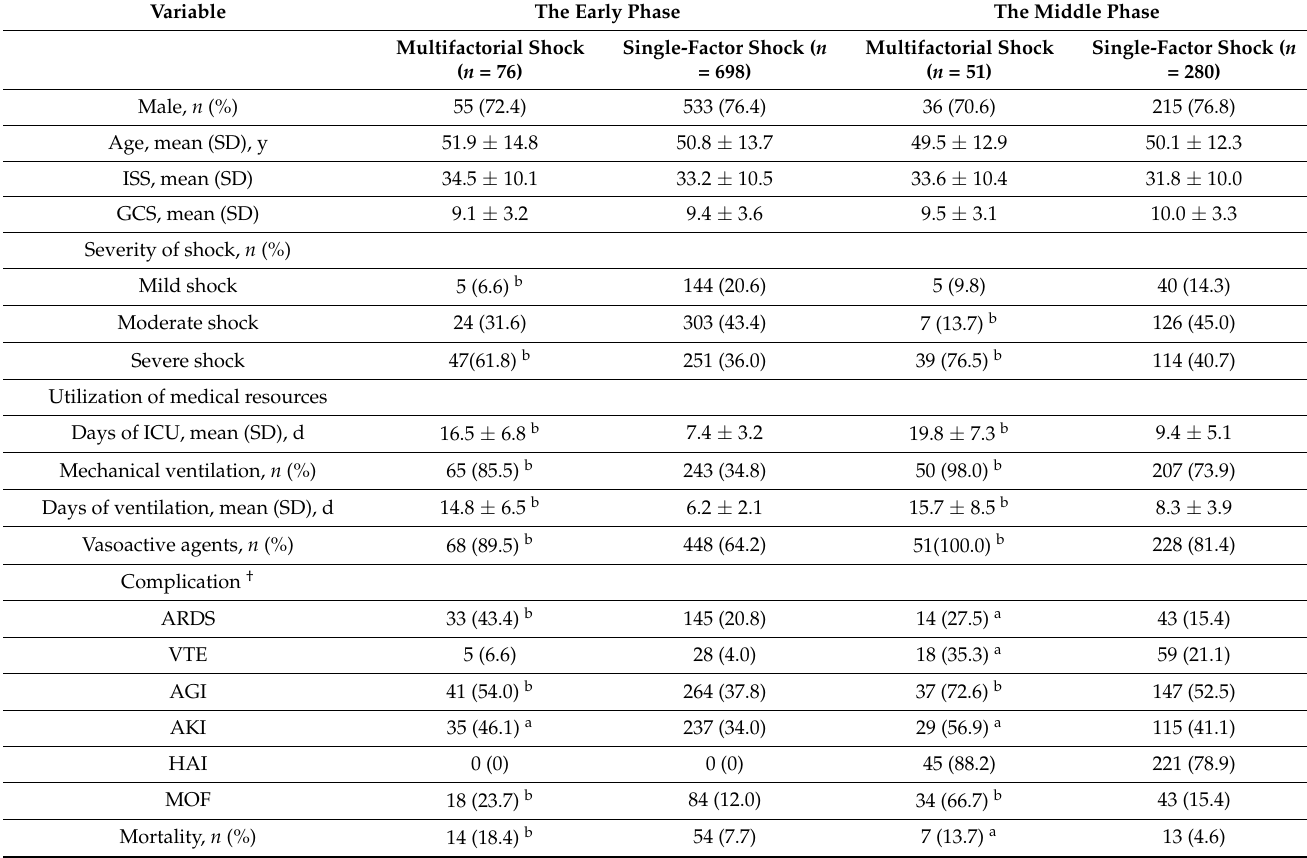
Table 5. Comparison of single-factor shock and multifactorial shock patients in different phases after